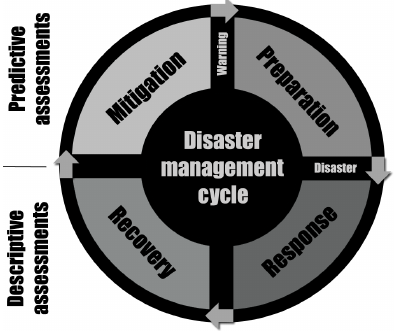
Figure 1. Disaster management cycle, a common paradigm